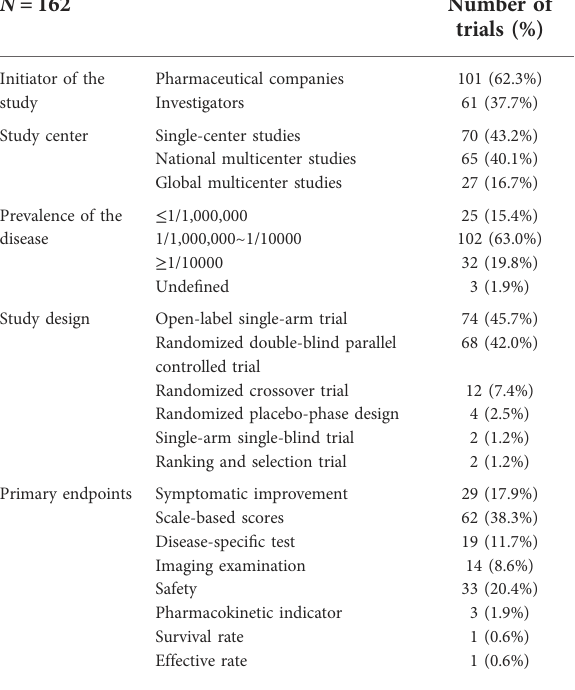
TABLE 1 Information of 162 clinical